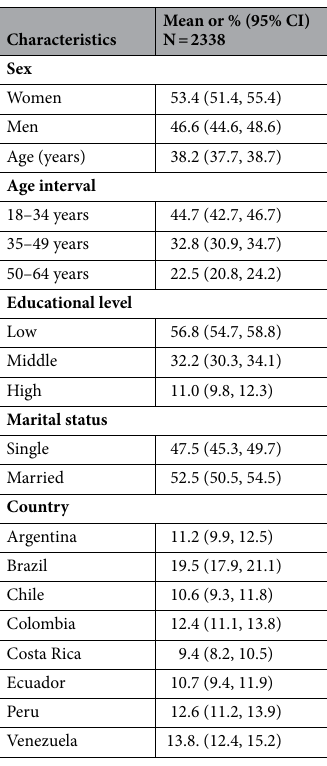
Table 1. Characteristics of participants (mean or percentage [95% CI]) according sociodemographic variables. 95% CI, 95% confidence